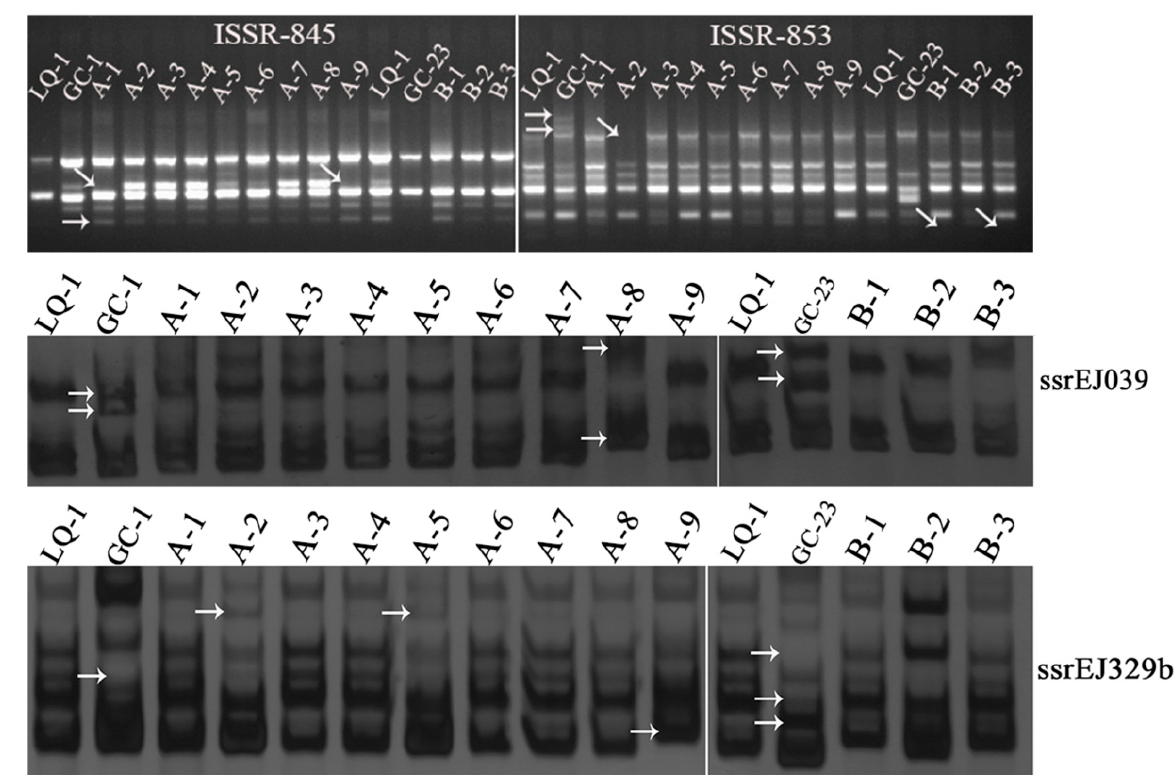
Figure 1. Typical ISSR and SSR profiles for triploid loquats and their parents. ISSR-845 and ISSR-853 were two ISSR markers; ssrEJ039 and ssrEJ329b were two SSR markers; LQ-1 was the tetraploid female parent; GC-1 and GC-23 were two diploid male parents; A-1, A-2, A-3…A-9 were the triploid hybrids of Triploid-A; B-1, B-2, and B-3 were the triploid hybrids of Triploid-B. The arrows indicated the sites of the polymorphic bands.